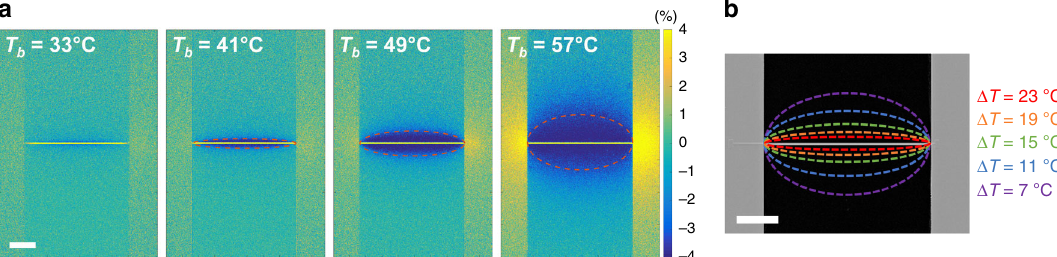
Fig. 3 Contour map of the temperature distribution induced by a Joule-heated nanowire. The wire (80 µ m × 1 µ m × 50 nm) on top of a glass substrate is coated with a 200-nm-thick fi lm of 1 and Joule-heated by the application of an electrical current of 4 mA. a Optical re fl ectivity ( λ = 452 nm) images Δ R / R = ( R − R R ON OFF )/ OFF of the nanowire recorded at selected base temperatures isotherm ( T SCO = 64 °C). b Contour map of the surface temperature acquired from gathering the isotherms for various base temperatures ( Δ T = T − T µ SCO b ). Scale bars, 20